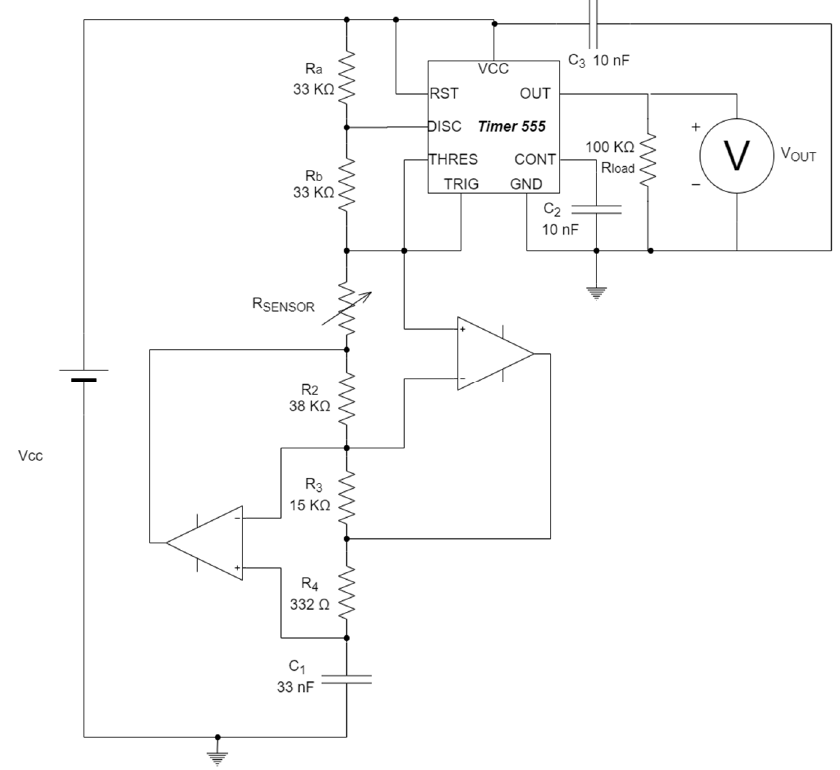
Figure 6. Final circuit of the converter resistance-to-frequency design.